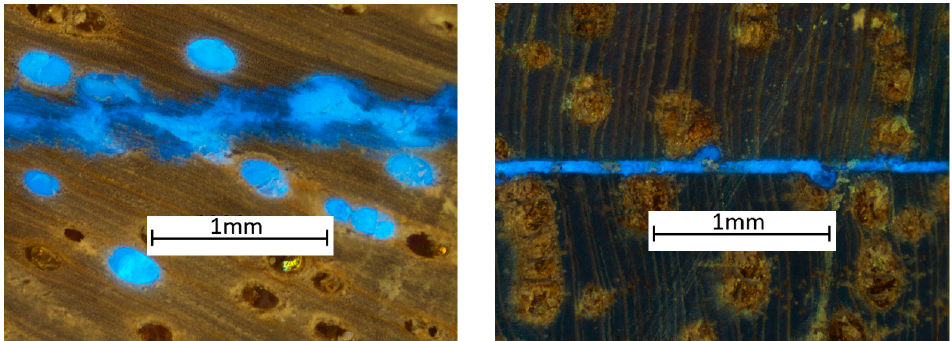
Figure 3. Contrasting adhesive (1C-PUR) penetration at 50× magnification in shining gum ( left ) and spotted gum ( right ).